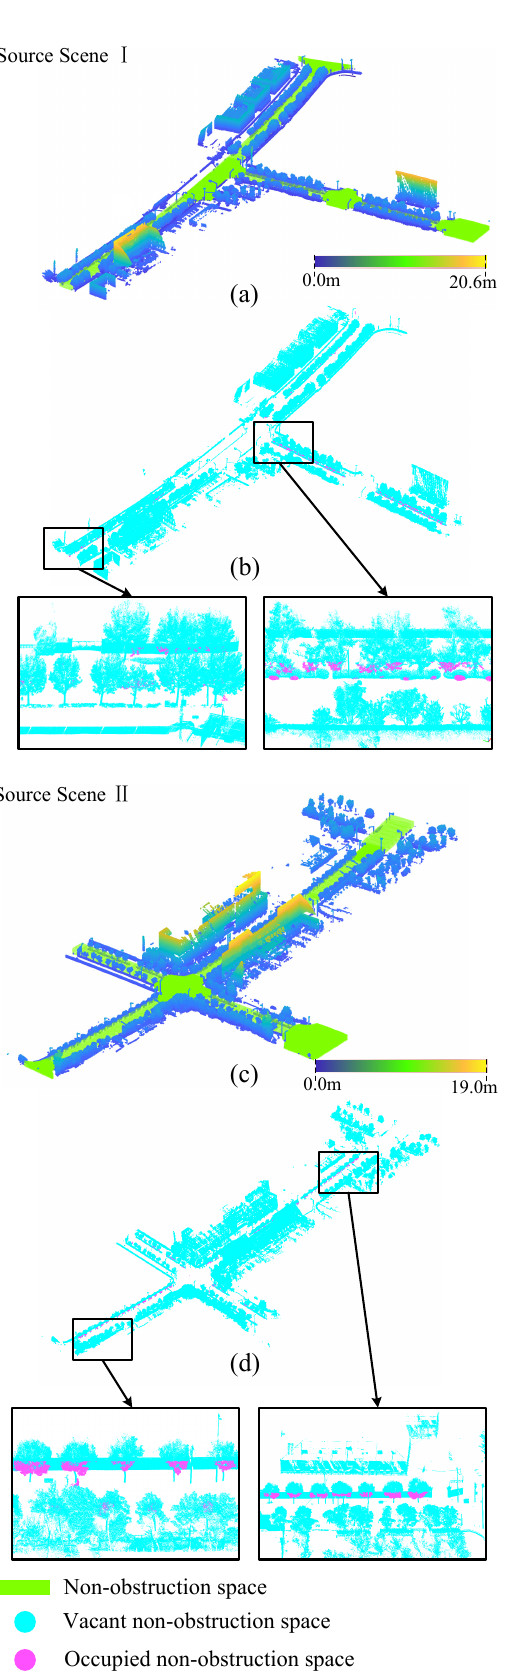
Figure 9. Examples of street obstruction analysis results: (a, c) The non-obstruction space of two scenes, (b, d) Obstructions detection results of two scenes.